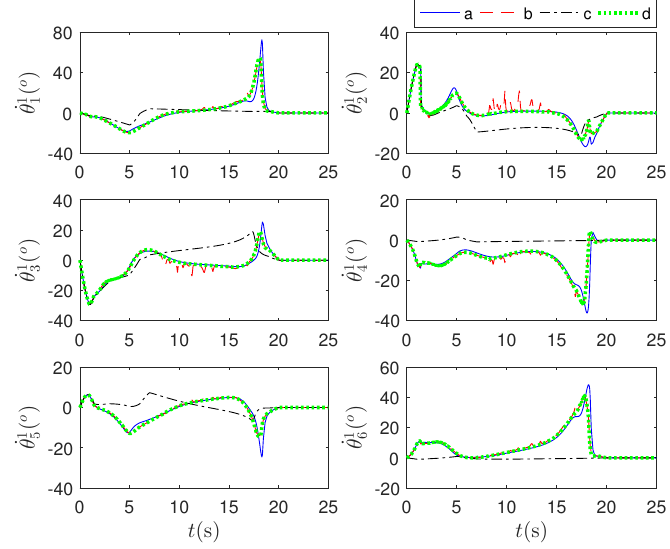
Figure 8. The joint angular velocity of mission arm in four methods.